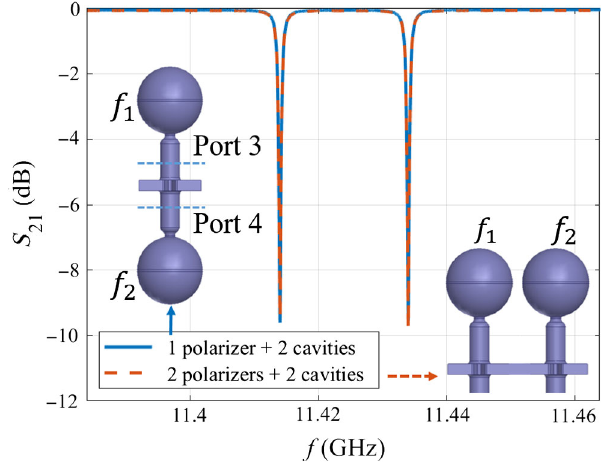
FIG. 3. Transmission spectra of the expanded polarizer with two cavities at different frequencies compared with two cascaded normal polarizers with the same